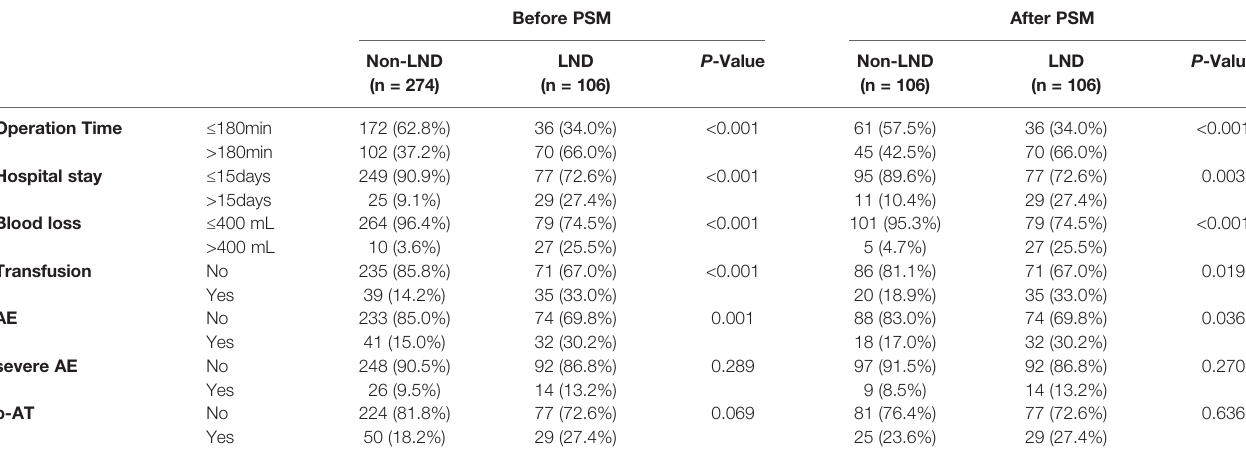
TABLE 2 | Operative and postoperative outcomes before and after